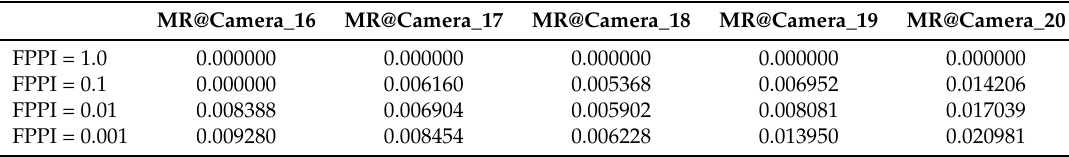
Table 15. Accuracy table @ Cameras_16–20, informed-filters, some